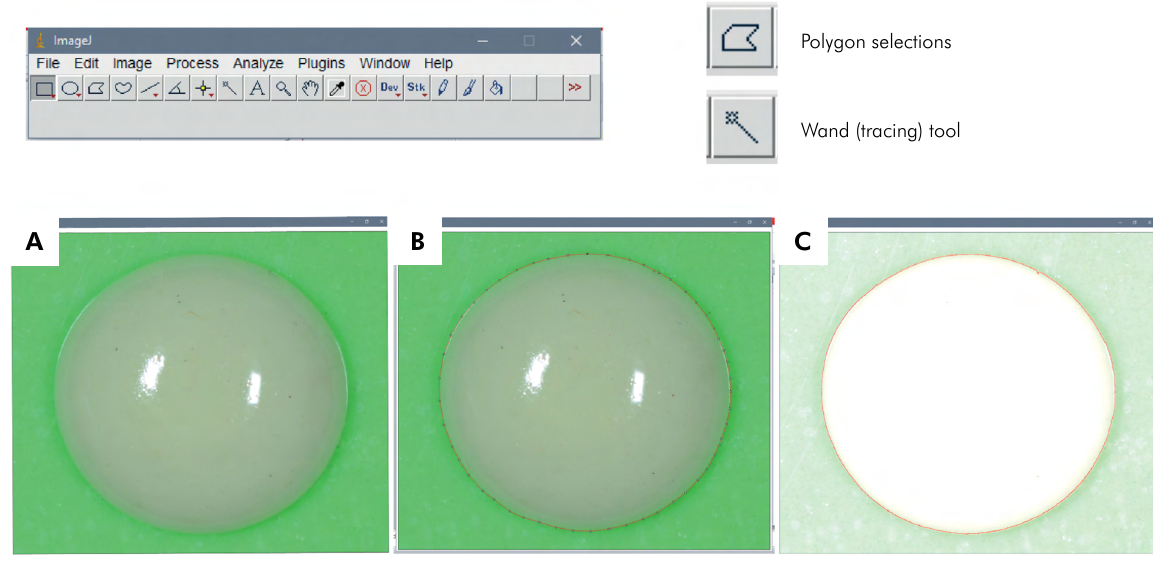
Figure 2. Analysis in the image analysis software (Image J) of the pre- and post-polymerization sample. Pre-polymerization image (A); the contours of the samples drawn on the captured images with Polygon Selections tool (B); Brightness adjustment for better outline visualization with the Wand Tool (C).